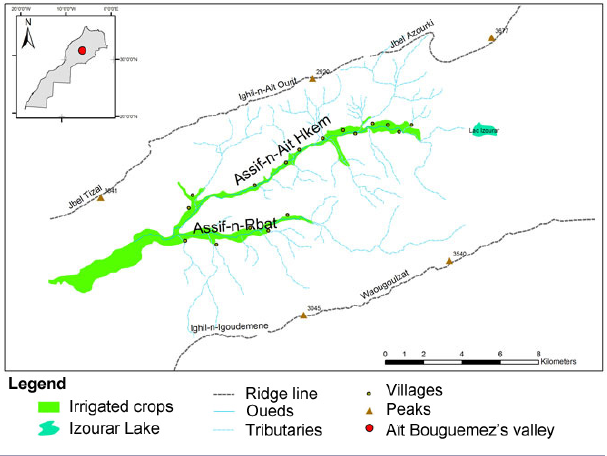
Fig. 1 . Location of the Aït Bouguemmez valley (central High Atlas, Morocco) (source: Hammi